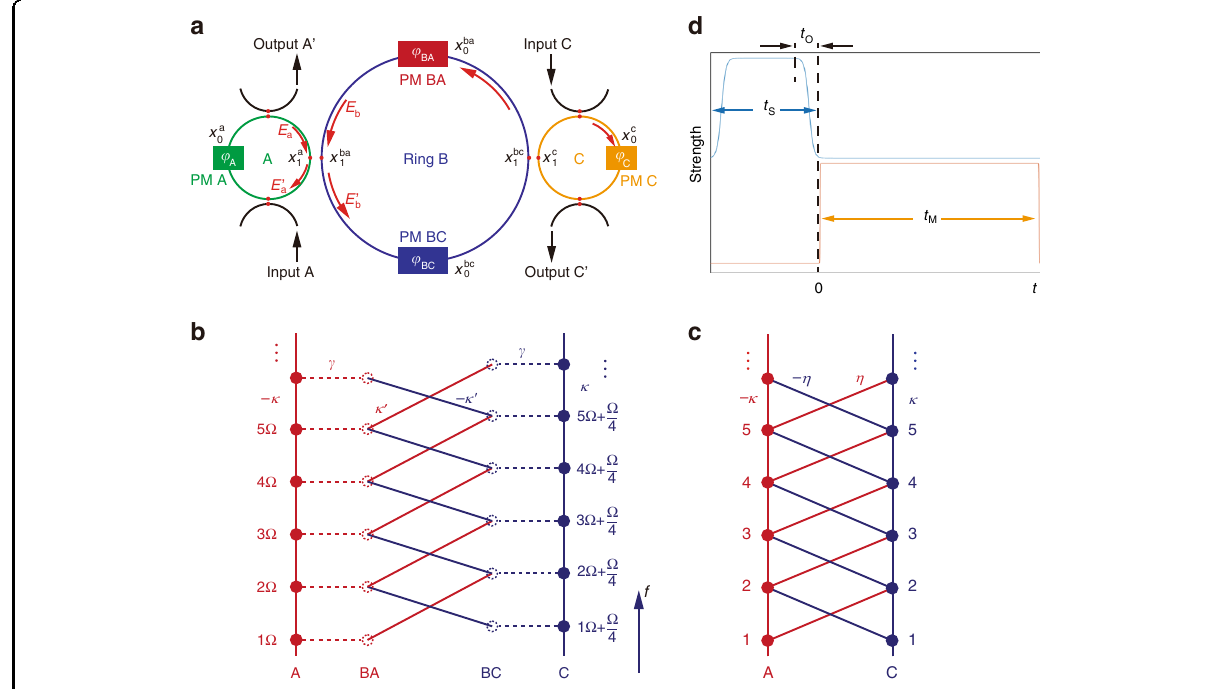
Fig. 1 Schematics of the model. a A schematic design of the ring-resonator system with phase modulators. External waveguides are used to input (output) signal. b The diagram shows couplings between modes A m (red solid dot) and BA m (red dashed dot) at frequencies ω A ; m ¼ m Ω and modes C m (blue solid dot) and BC m (blue dashed dot) at frequencies ω C ; m ¼ m Ω þ Ω = 4. Modulators induce nearest-neighbor couplings (solid line) between nearby modes along the frequency axis of light; modes in different rings are coupled through the evanescent wave (dashed line). Red (blue) solid lines denote couplings induced by modulator PM BA (BC). For the nontrivial case, ϕ A ¼ ϕ BC ¼ π and ϕ C ¼ ϕ BA ¼ 0 in modulators give negative and positive couplings, respectively. c The effective tight-binding model of the pseudospin lattice in the nontrivial case ( ϕ ¼ π ). d Time sequences of input source ( t S ) and modulation ( t M ) in simulations. t O is the turn-on/turn-off